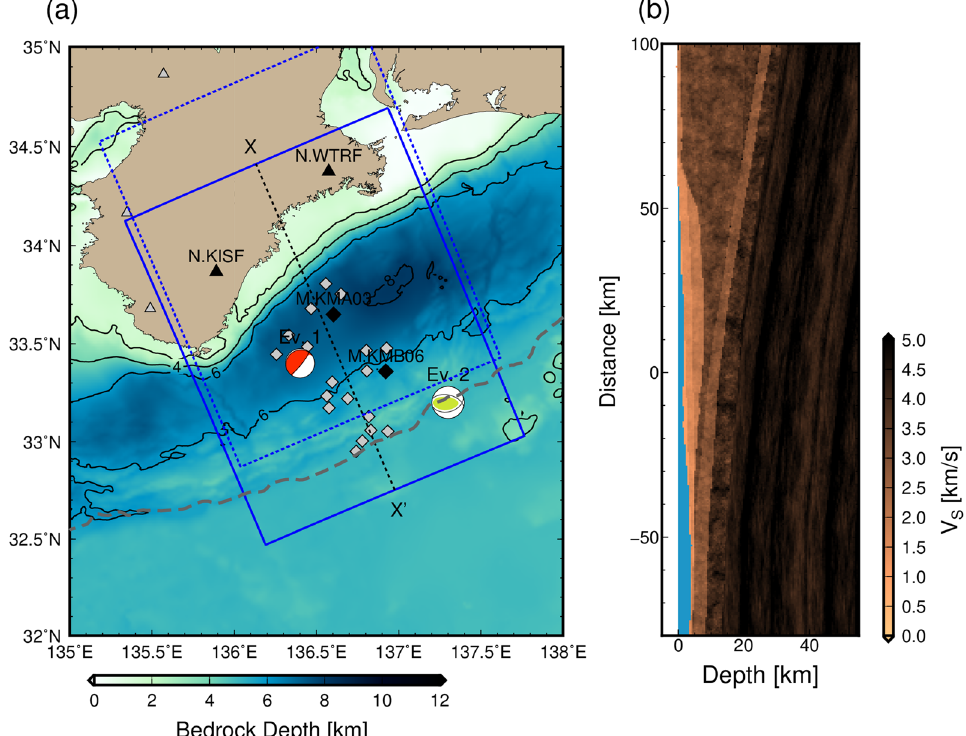
Fig. 2 Map view and cross-section of our simulation model. The blue solid rectangle in a is the horizontal coverage of our simulation model for Fig. 7–Fig. 12. The blue dotted rectangle is also the horizontal coverage of the simulation model but for Figure S1 only. Plotted focal mechanisms of Events 1 and 2 were the source models used in this study. The colors in focal spheres of Events 1 and 2 are representing focal depths same as in Fig. 1a. The background color and contour lines represent the bedrock depths of Koketsu et al. (2012). The gray, bold, dashed line in a is the deformation front (Nankai Trough). The cross-section of S -wave velocity structure along the X-X’ profile in a is shown in b . The X-axis is the X direction in